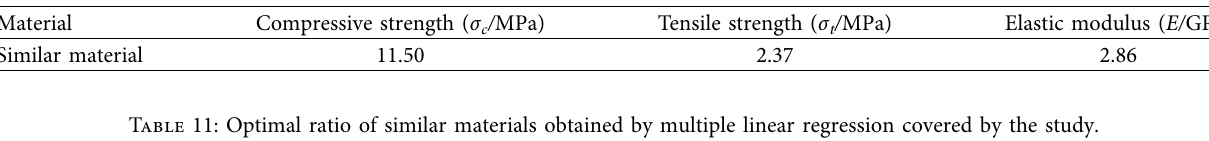
Table 10: Mechanical parameters of similar materials covered by the study.